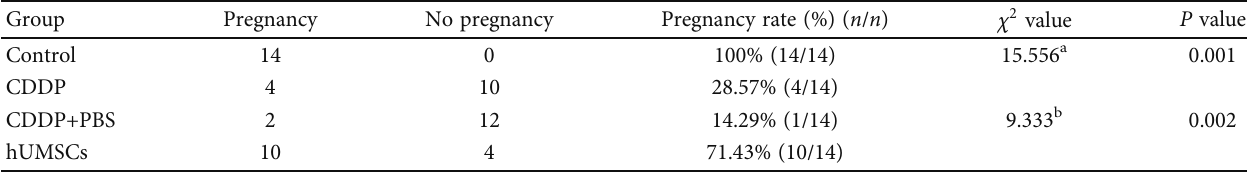
Table 1: Pregnancy rates of rats in each group.